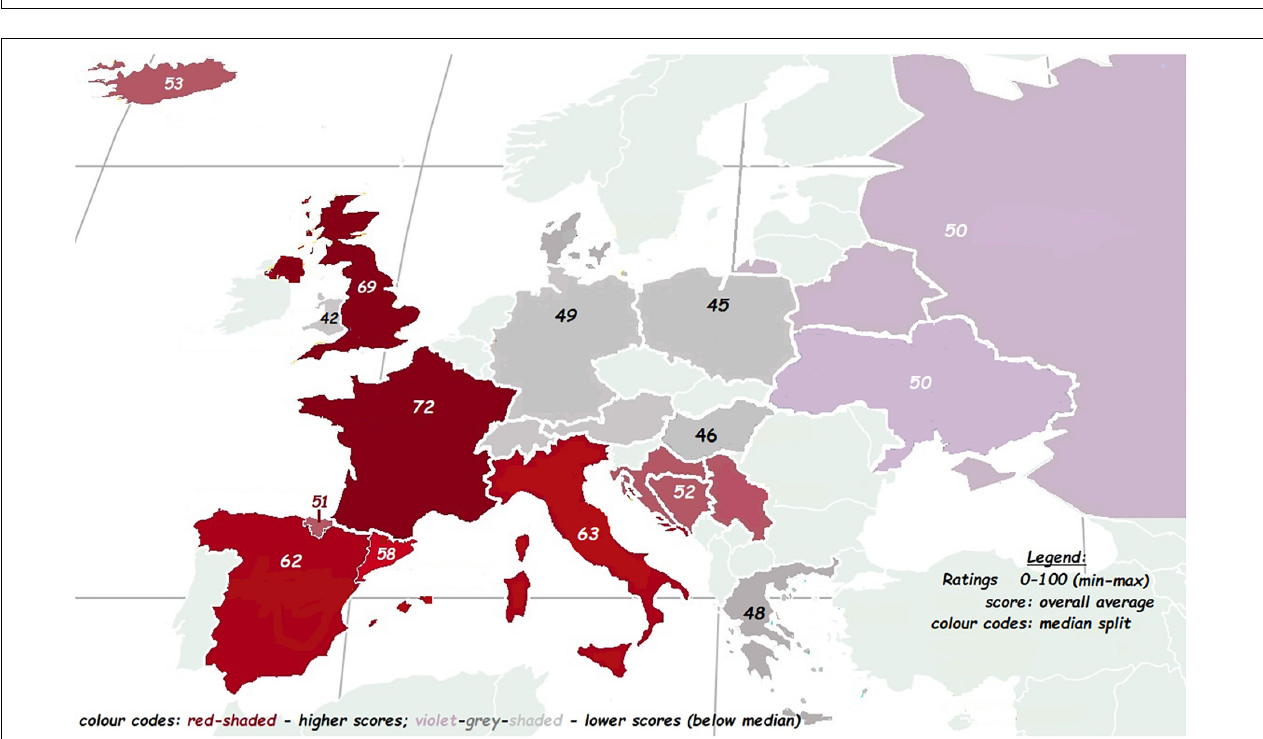
FIGURE 3 | Mean (overall) aesthetic rating per language displayed on a geographical map. Color codes reflect the median split of the overall aesthetic ratings per language; red colors reflect higher ratings and violet or gray shaded reflect the lower ratings (0–100 min-max).